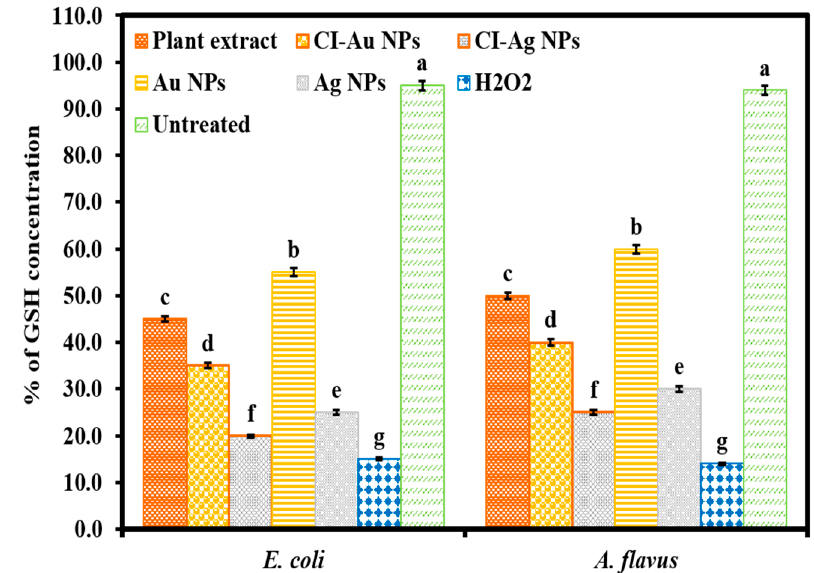
Figure 10. The level of GSH concentration in E. coli and A. flavus treated with C. inerme leaves extract, CI-Au NPs, CI-Ag NPs, Au NPs, and Ag NPs. (Note: Tukey based heterogeneous lower-case letters represent significant statistical pairs).